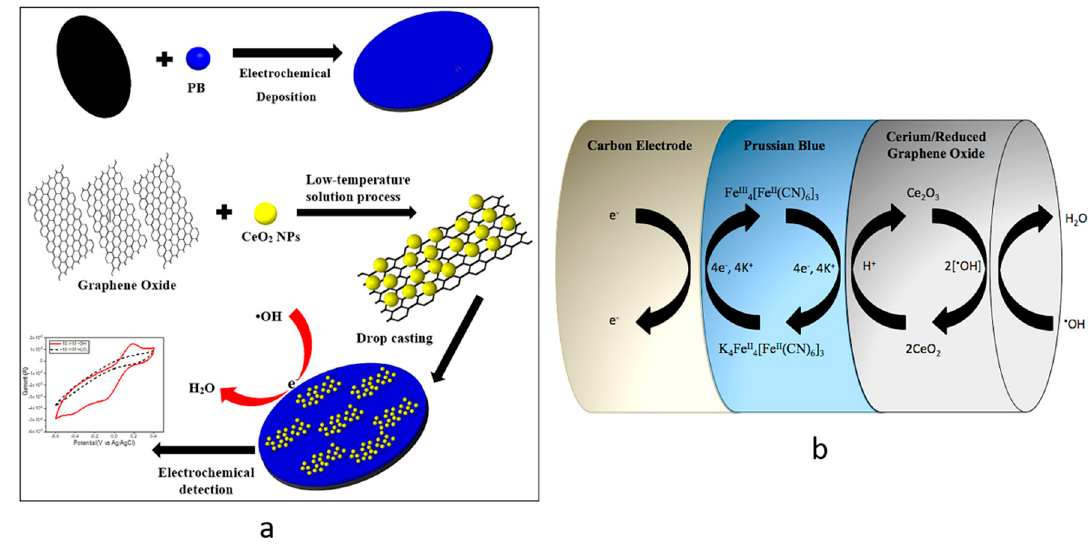
Figure 2. ( a ) Schematic of the construction and test processes for the composite sensor, ( b ) the mechanism of detection of hydroxyl radicals in the sensor design.